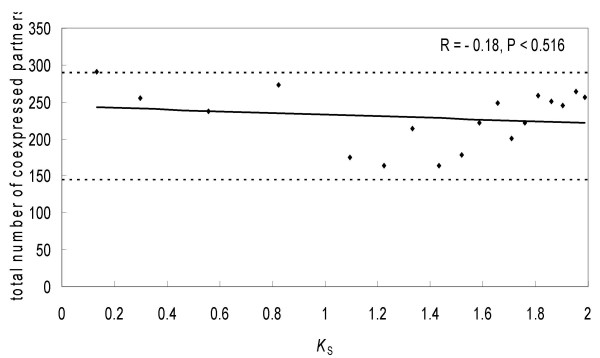
The change in the total number of coexpressed partners with evolutionary time (measured by KS). Each point represents an average value for 40 duplicate gene pairs. The lower dashed line is the average number of partners for a singleton and the upper dashed line is twice the average number of partners for a singleton.